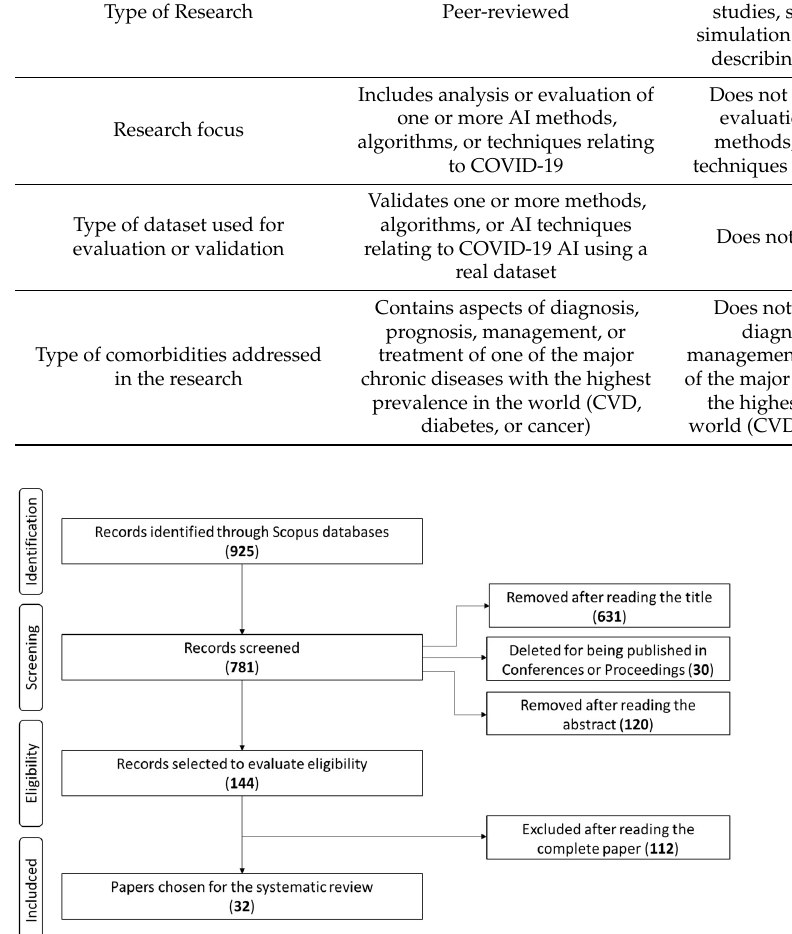
Figure 1. PRISMA flow diagram at four levels, based on “ Search equation ”.